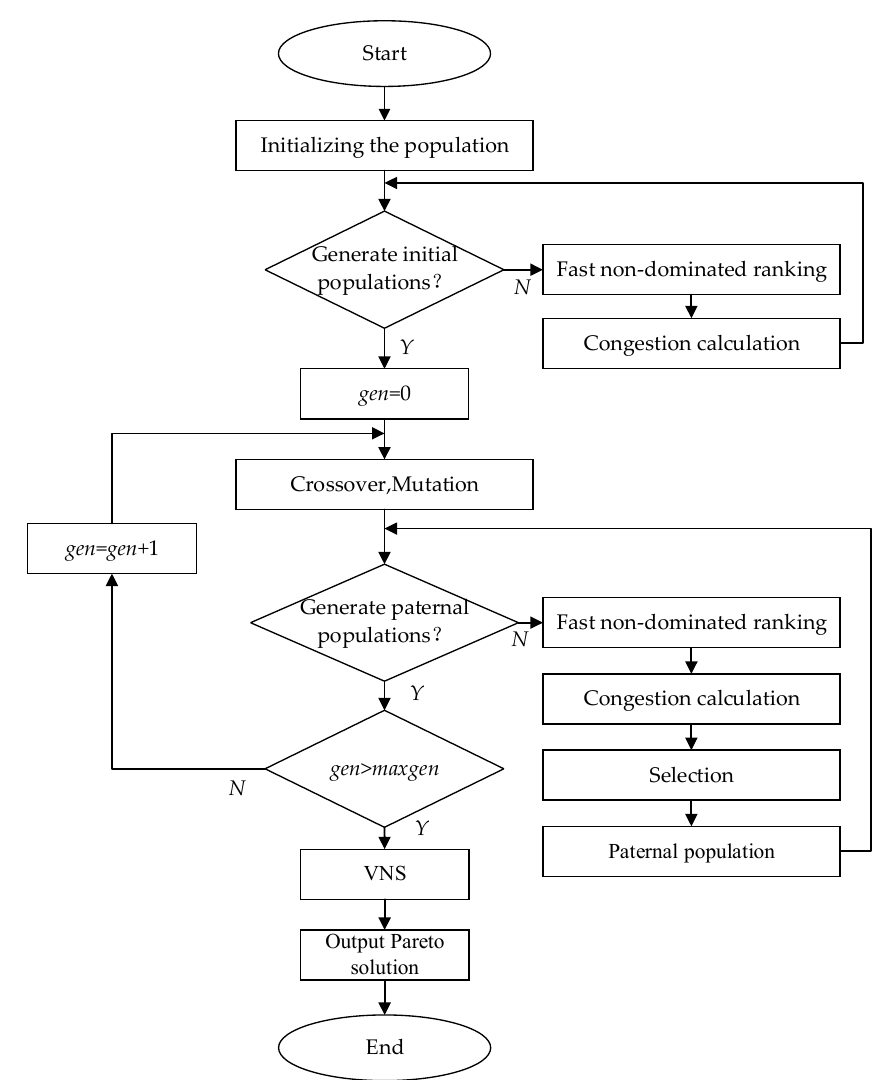
Figure 3. Improved NSGA- Ⅱ -V flow chart.